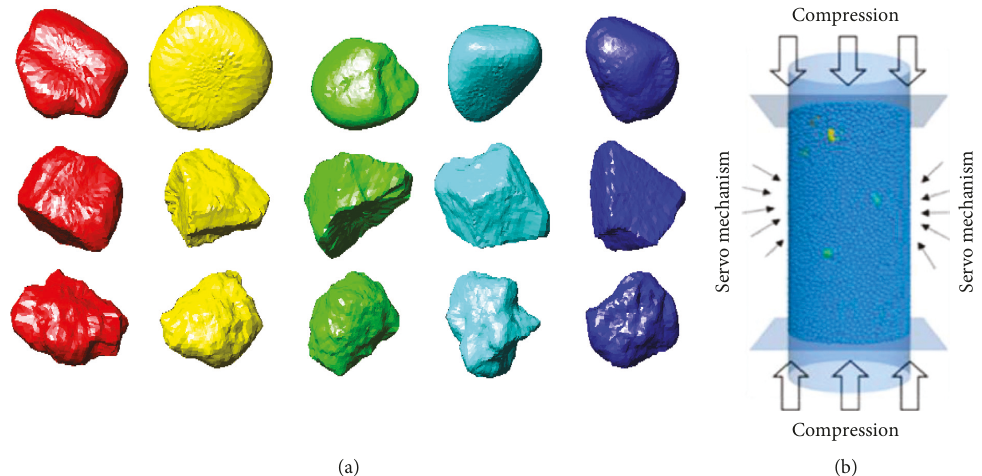
Figure 3: Three-dimensional compression device. (a) Structure of different framework particles; (b) numerical test device.